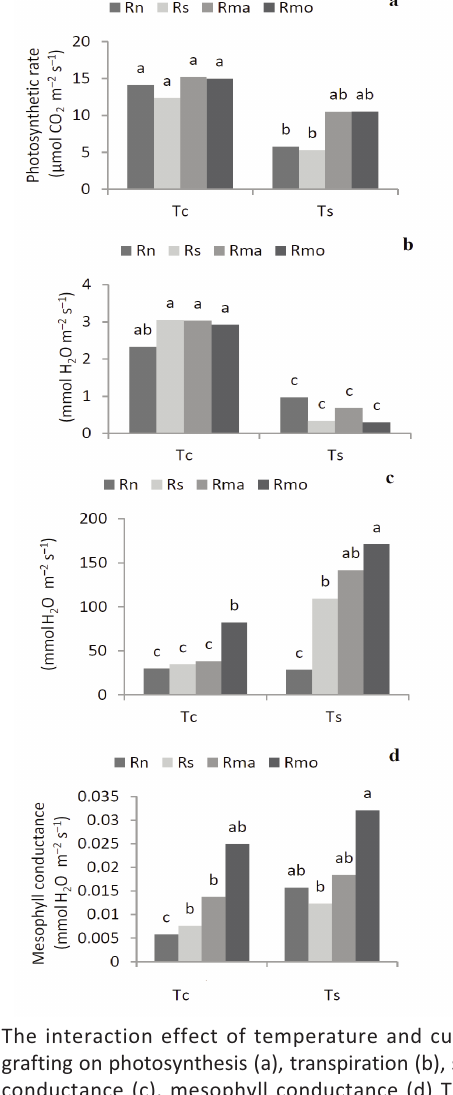
Fig. 7 ­ The interaction effect of temperature and cucumber grafting on TSS (a) and firmness (b). Tc= optimum tempe­ rature, Ts= low temperature; Rn = nongrafted ( Cucumis sativus var. DavosII); Rs= self grafted; Rma= Cucurbita maxima ; Rmo= Momordica charantia.